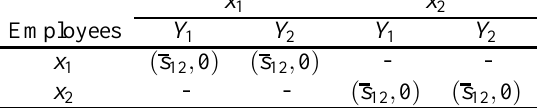
Table 3. Unified assessments from each employee about them- selves